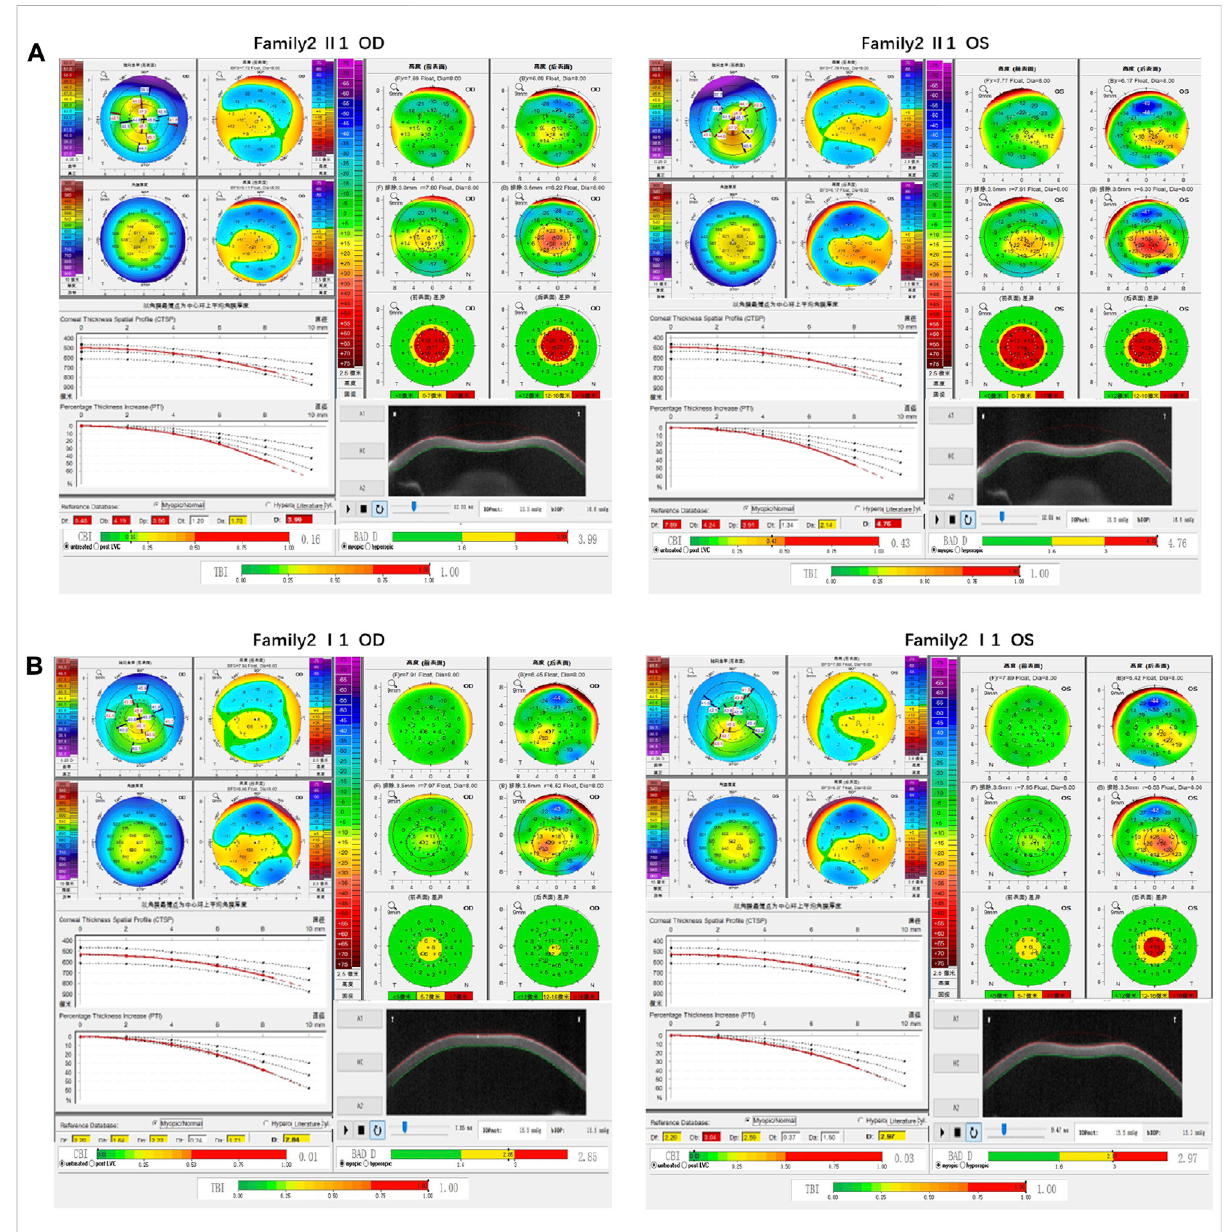
FIGURE 3 Corneal topographic map and corneal biomechanical examination in family 2. (A) For proband Ef, Eb, Df, Db, Dp, Da, D, BAD-D, CBI and TBI showing pathological values (red) and curvature: Kmax 47.6 D in the right eye and 48 D in the left eye (B) BAD-D, Df, Db, Dp, Dt, Da showing suspicious values (yellow) and TBI, Eb showing pathological values (red) in the father of